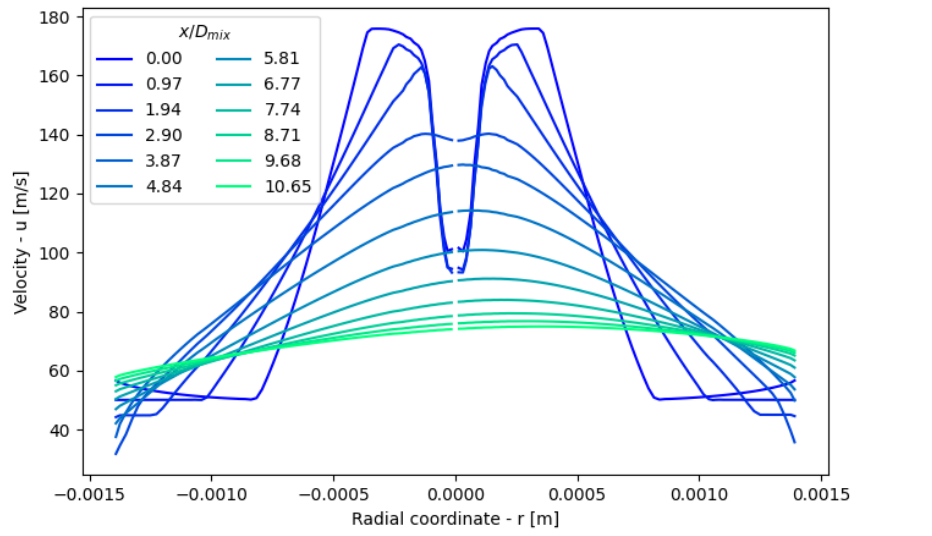
Figure 15. Velocity plot in the y direction. Positive r direction is in the direction furthest offset from the flow path of the bypass inlet, θ bp = 270 ◦